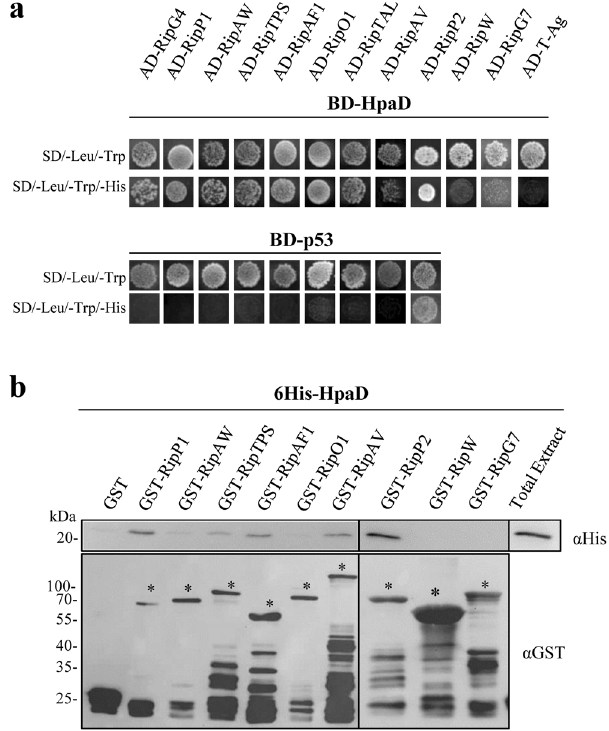
Figure 4. R . solanacearum HpaD interacts with eight type III effectors. ( a ) Yeast cells were co-transformed by BD-HpaD and 38 AD-T3Es. Double transformation and interactions were tested by plating yeasts on synthetic dropout medium lacking leucine and tryptophan (SD/–Leu/–Trp) and synthetic dropout medium lacking leucine, tryptophan and histidine (SD/–Leu/–Trp/–His), respectively. RipW and RipG7 have the same profile as 27 other T3Es tested. BD-p53 and AD-T-antigen were used as negative controls. Three biological replicates were performed and gave same results. ( b ) Glutathione S-transferase (GST) and GST-T3Es were immobilized on glutathione sepharose and incubated with an E . coli lysate containing 6His-HpaD. Total cell lysates and eluted proteins were analyzed using antibodies directed against GST and the 6His epitope. Bands corresponding to GST and GST fusion proteins are marked by asterisks; lower bands represent degradation products. For lack of space, samples have been loaded into two gels (black line separation). The experiments have been repeated twice with similar